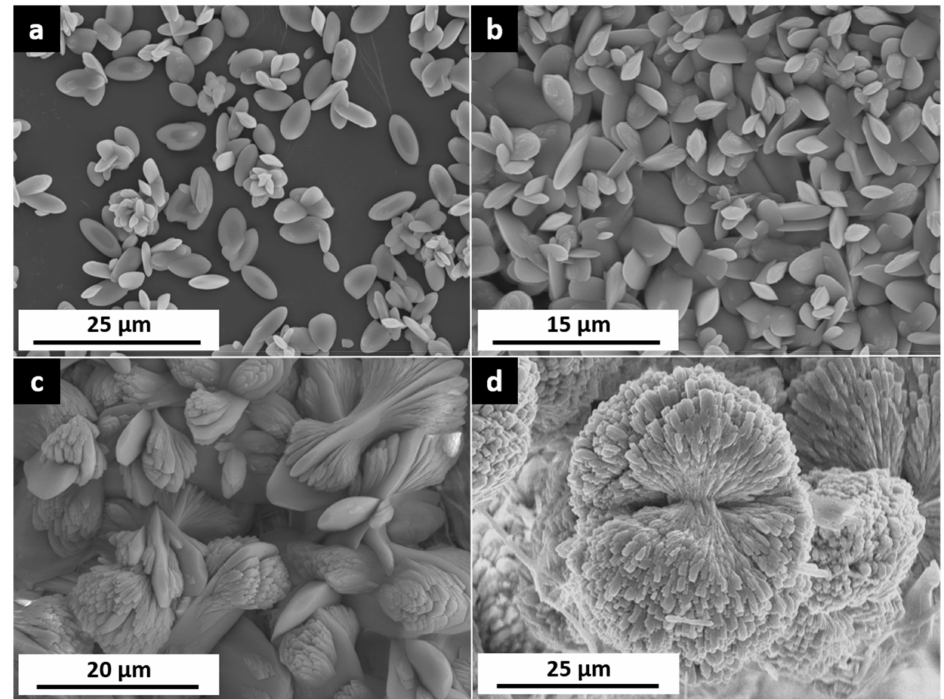
Figure 2. ( a ) SEM micrographs of micrometer-sized celestite crystals formed on a gypsum (010) surface after 10 min interaction with a 0.5 M Sr-bearing aqueous solution. Celestite crystals are initially bone folder-shaped. ( b ) After 30 min of interaction the whole (010) gypsum surface appears carpeted with celestite crystals. ( c , d ) With increasing elapsing time, celestite crystals gradually evolve from single crystals to crystal aggregates that are either ( c ) sheaf-life shaped (interaction time = 3 h) or even ( d ) spherulitic (interaction time = 1